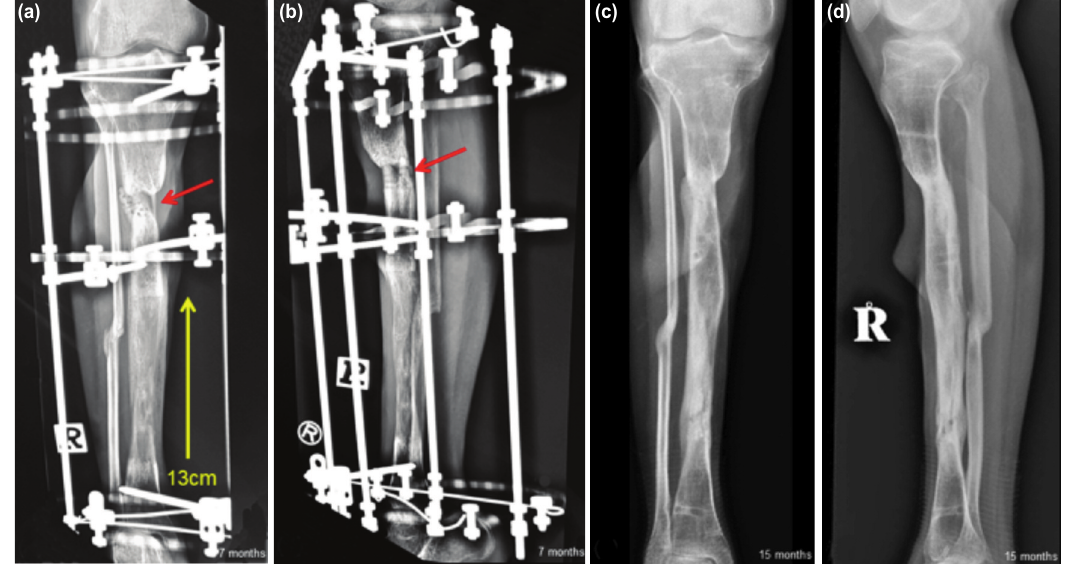
(a) Anteroposterior and (b) lateral radiographs of the right tibia at seven months following bone transport with the Ilizarov Fig. 3: method. Red arrows showing multiple drilling over the docking site performed two months previously with injections of peripheral blood stem cells to enhance callus formation. Yellow arrow indicating the direction of bone transport from the ankle corticotomy site, showing 13cm of bone regeneration over the distal half of the tibia. Similar views (c) and (d) at 15 months, showing bone healing at the docking site and further consolidation of the regenerated